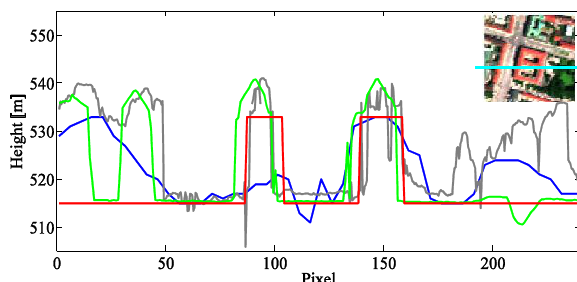
Figure 6: Comparison of approximated building boundaries and DSMs in vertical profile (the position of the profile is marked on the upper right image with a cyan line). CartoSat DSM (blue), WV2 DSM (gray), laser DSM (green) and approximated building boundaries (red) of the building in the centre.